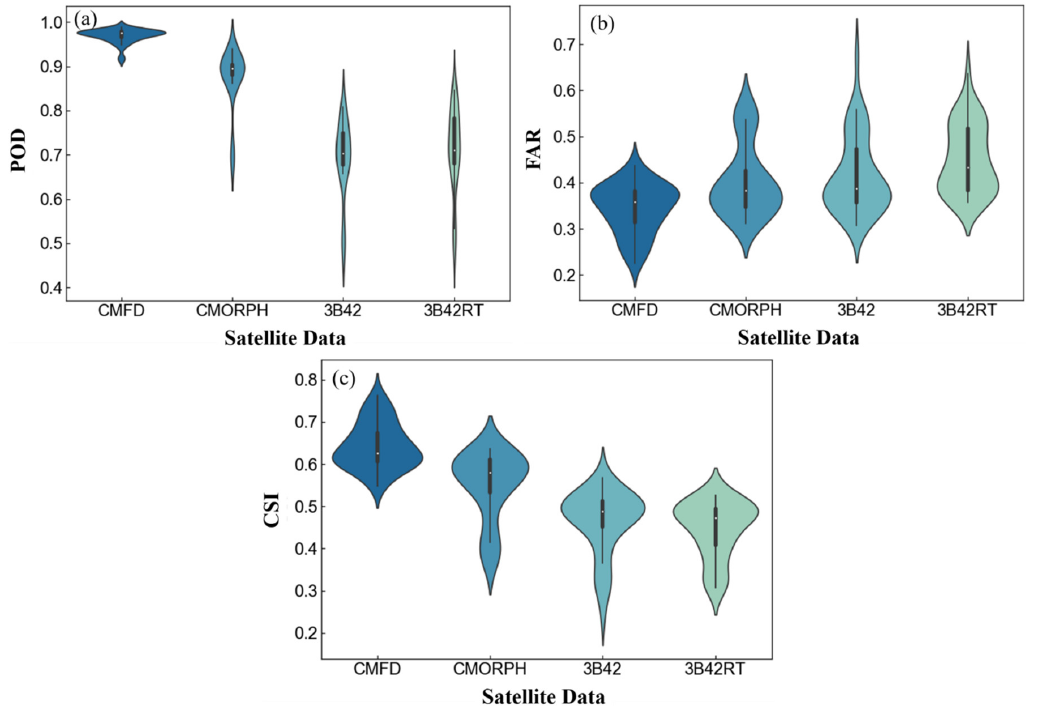
Figure 4. Variation in the categorical metrics for four satellite precipitation products against observed precipitation data over Beijing ( a ) POD, ( b ) FAR, and ( c ) CSI.